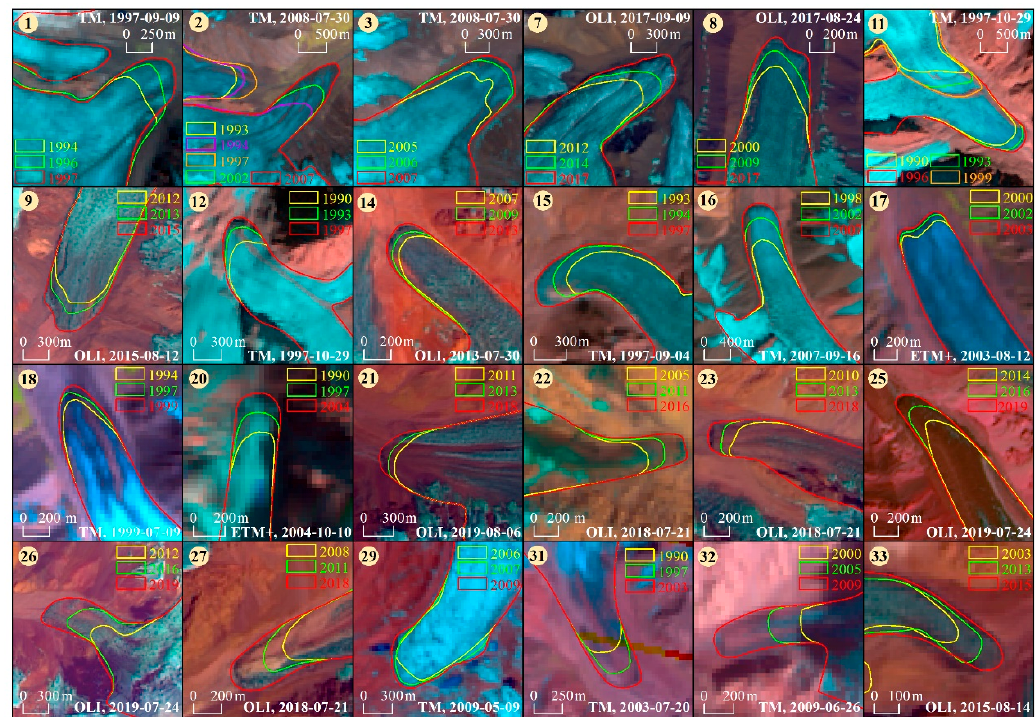
Figure 7. Changes in the termini of advancing glaciers in the Tien Shan Range. Figures shows the beginning (yellow), middle (green), and end (red) glacial boundaries in various years and with remote sensing images of advancing glaciers (refer Table 1 for glacier numbers): glaciers 1, 2, 3, 7, 8, 11, 9, 12, 14, 15, 16, 17, 18, 20, 21, 22, 23, 25, 26, 27, 29, 31, 22, and 33 from different dates acquired using Landsat Thematic Mapper (TM), Enhanced Thematic Mapper (ETM+), and Operational Land Imager (OLI) imagery.